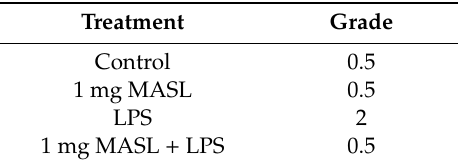
Figure 4. MASL attenuates nuclear factor kappa B p65 activation. ( A ) Western blot analysis of phospho-IkB-α and NF-kB in primary chondrocytes in monolayer culture, untreated (U) and treated with 400 nM MASL (M and O/M) or 5 µg/mL of oligomycin (O) for 1 h. α-tubulin and ponceau staining were used as loading controls. p-Ikß quantification is shown below. Representative experiment of n = 3. ( B ) Detection of NF-kB (p65) in red by immunofluorescence. Nuclei were stained with DAPI. Primary chondrocytes were treated for 1 h with MASL (400 nM) and 5 µg/mL oligomycin. Scale bar, 50 µ m. Quantification is shown on the right. Values indicate percentage of cells. The data are presented as the mean ± SEM (n = 3), * p < 0.05; Mann–Whitney test. ( C ) Detection of NF-kB (p65) by immunofluorescence in primary chondrocytes treated with 10 ng / mL TNF- α and 400 nM MASL for 1 h. Scale bar, 50 µ m. Quantification is shown on the right. Values indicate percentage of cells. The data are presented as the mean ± SEM (n = 3), * p < 0.05; Mann–Whitney test; ( D ) mRNA levels of IL-6 in primary chondrocytes exposed to MASL (400 nM) and / or 5 µ g / mL of oligomycin for 1 h. The data are presented as the mean ± SEM (n = 3). * p < 0.05, ** p < 0.01; Mann–Whitney test. Table 1. Semiquantitative scoring of articular cartilage. Glasson S.S. et al. method with Chambers et al. modifications [63,64] was used to score mice articular cartilage (loss of Safranin-O, structural changes, erosion, small fibrillations among other factors). The grade of each group was calculated using the average score obtained for each sample and group (n = 4).